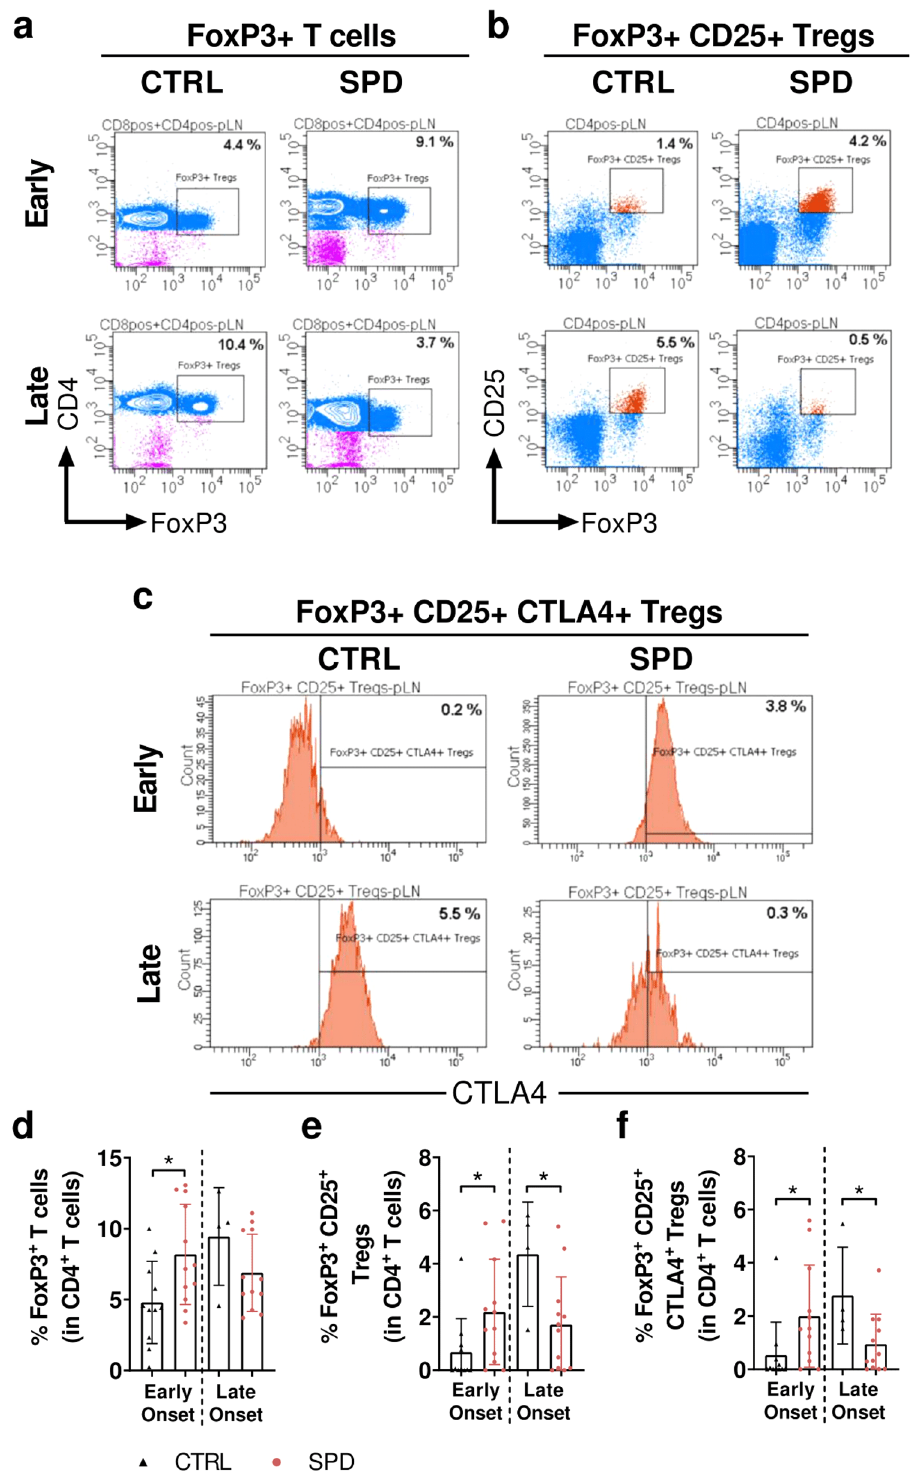
Figure 7. Daily oral spermidine treatment increased the proportion of Tregs in female early onset spd mice and decreases the proportion of Tregs in late onset spd mice. Representative images of gating strategy are shown in ( a ) FoxP3+ T-cells, ( b ) FoxP3+ CD25+ Tregs and ( c ) FoxP3+ CD25+ CTLA4+ Tregs ( d ) Proportion of FoxP3+ T-cells, ( e ) FoxP3+ CD25+ Tregs and ( f ) FoxP3+ CD25+ CTLA4+ Tregs were examined in pLN of early and late onset mice. Diabetic mice were grouped as early onset (< 21 weeks of age) and late onset (≥ 21 weeks of age). Early onset ctrl mice (n = 11), early onset spd mice (n = 12), late onset ctrl mice (n = 4), late onset spd mice (n = 12). Black triangles indicate diabetic ctrl mice and red circles indicate diabetic spd mice. Data is shown as mean ± SD. Mann–Whitney U test or unpaired Student ’ s t -test was used as statistical analysis to compare ctrl and spd mice. p * <